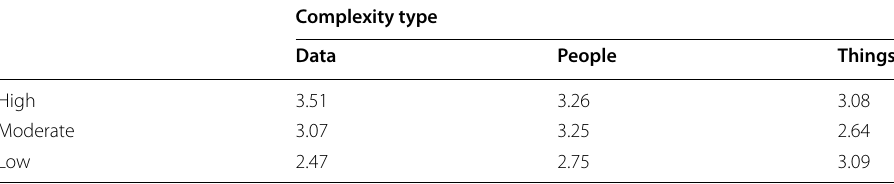
Table 10 Mean of complex problem solving at work, at different levels of occupational complexity. Source: PIAAC 2012, DOT index, ISCO-08